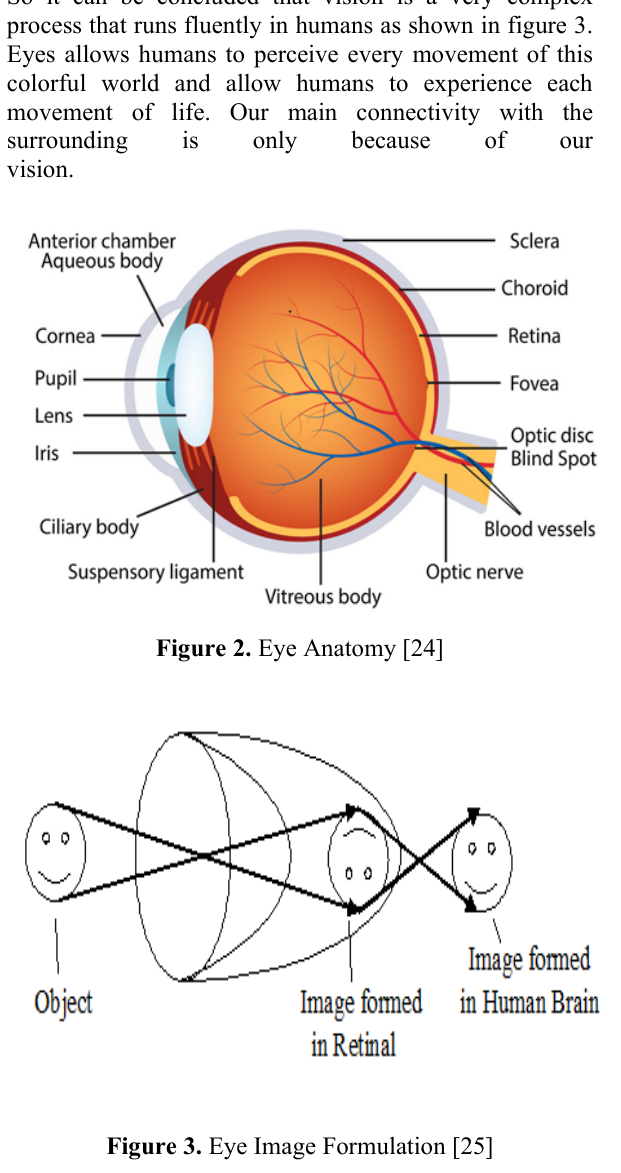
Figure 3. Eye Image Formulation